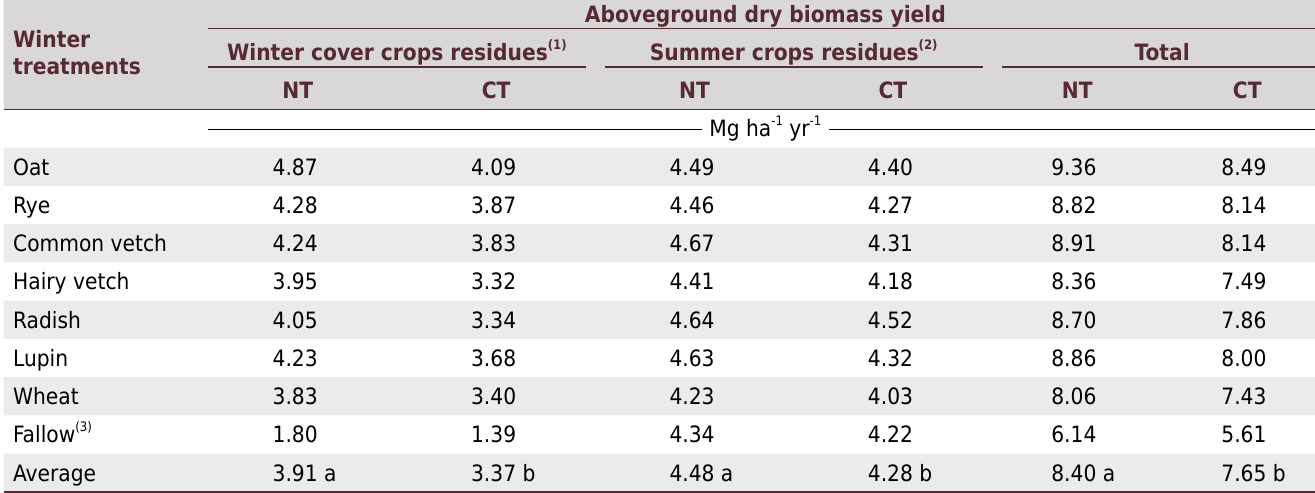
Table 1. Total aboveground dry biomass yields over 26 years in different winter treatments and soil tillage systems Winter